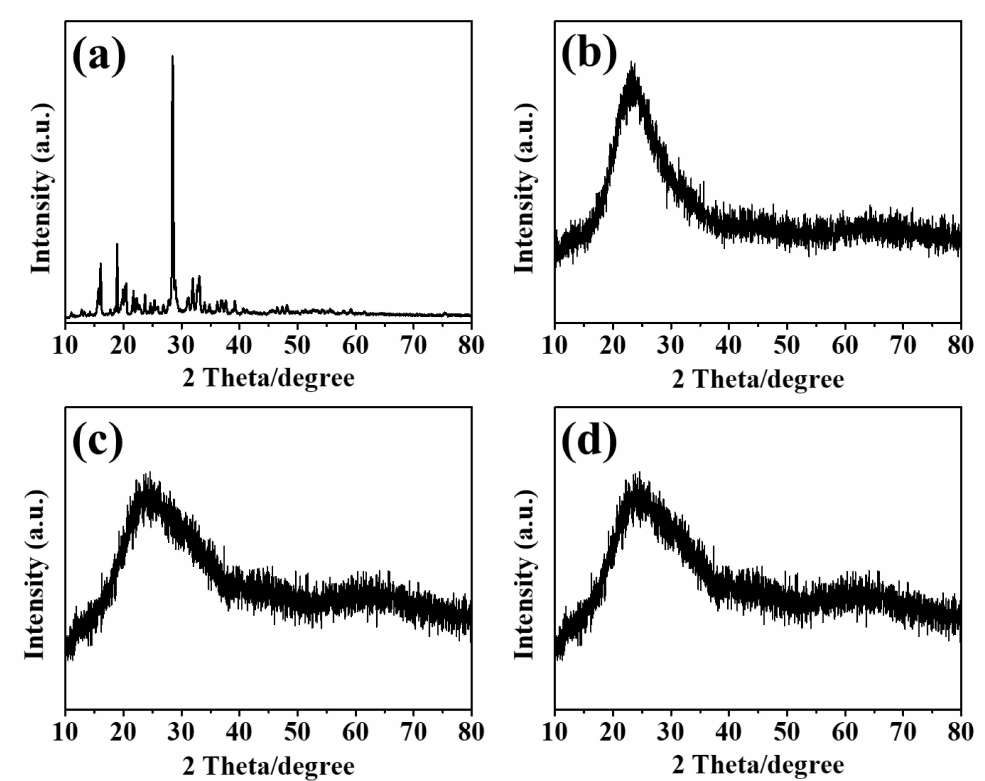
Figure 5. Wide-angle XRD patterns of ( a ) 5-FU, ( b ) MCM-41_5-FU, ( c ) MCM-41-PAA_5-FU, and ( d )